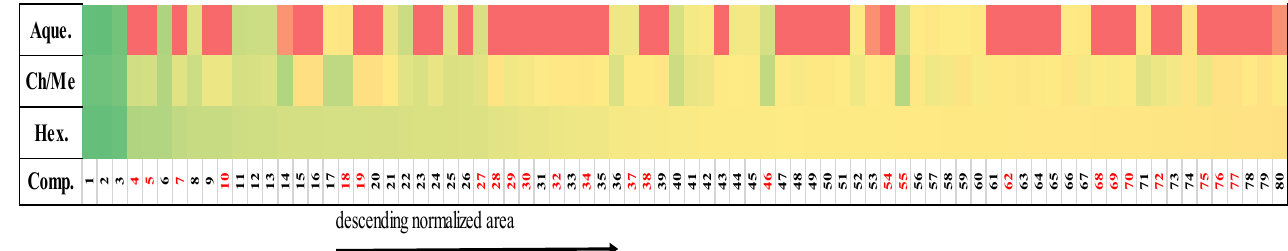
Figure 4. Heat map with the distribution according to the normalized areas of the 80 shared metabolites, identified in the active extracts. Metabolites with previous reports of cytotoxic activity are highlighted in red. Aque* : Aqueous extract;